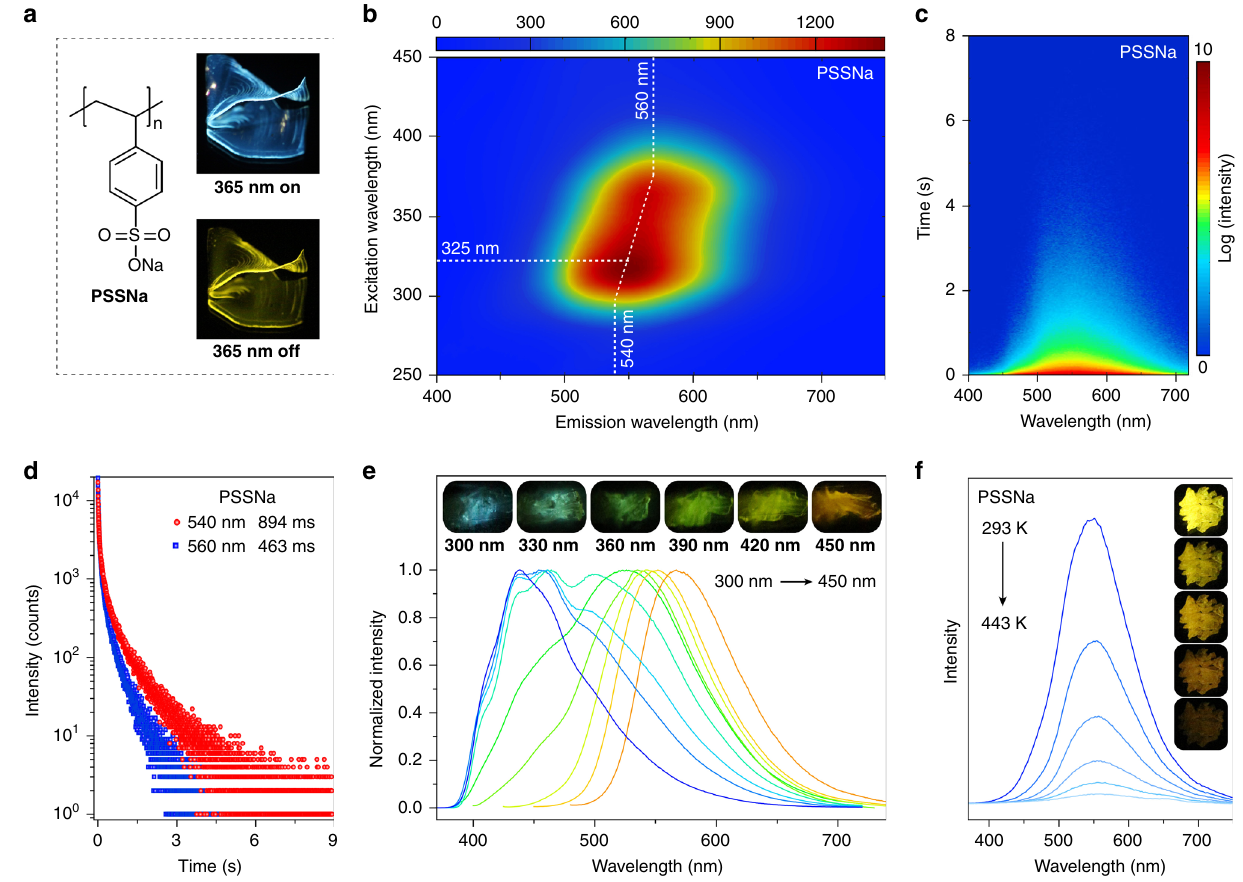
Fig. 2 Photophysical properties of dry PSSNa polymer in solid state. a Molecular structure of PSSNa polymer. Right: Photographs of PSSNa solids taken under a 365 nm lamp on and off. b Excitation-phosphorescence emission mapping of PSSNa polymer under ambient conditions. c Time-resolved emission spectra of PSSNa polymer excited by 325 nm. d The lifetime pro fi les of PSSNa polymer monitoring at 540 nm excited by 300 nm and 560 nm excited by 365 nm under ambient conditions, respectively. e Excitation dependent phosphorescence spectra of PSSNa polymer at 77 K. Insets show photographs taken after PSSNa polymer excited by 300, 330, 360, 390, 420, and 450 nm at 77 K. f Phosphorescence spectra of PSSNa polymer at various temperatures from 293 to 443 K. Insets show photographs from top to bottom taken after PSSNa polymer excited by 365 nm at 293, 348, 373, 418, and 443